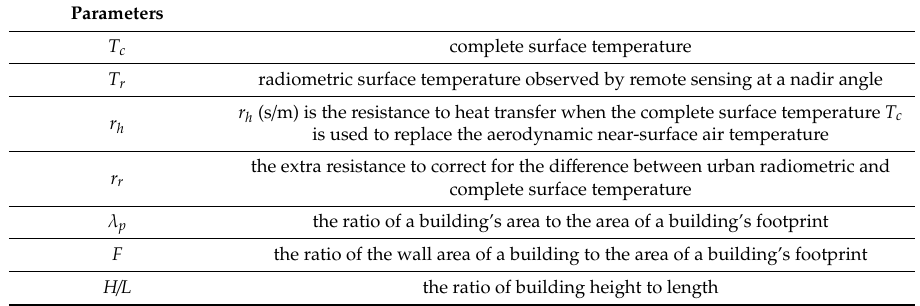
Table 1. Definitions of the di ff erent temperatures, resistances, and geometric parameters used in this